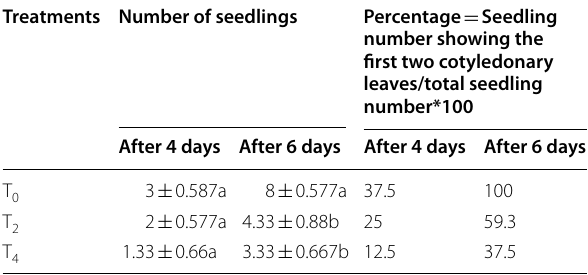
Table 3 Effect of NaCl stress on the appearance of the first two cotyledonary leaves of tomato seedlings Treatments Number of seedlings